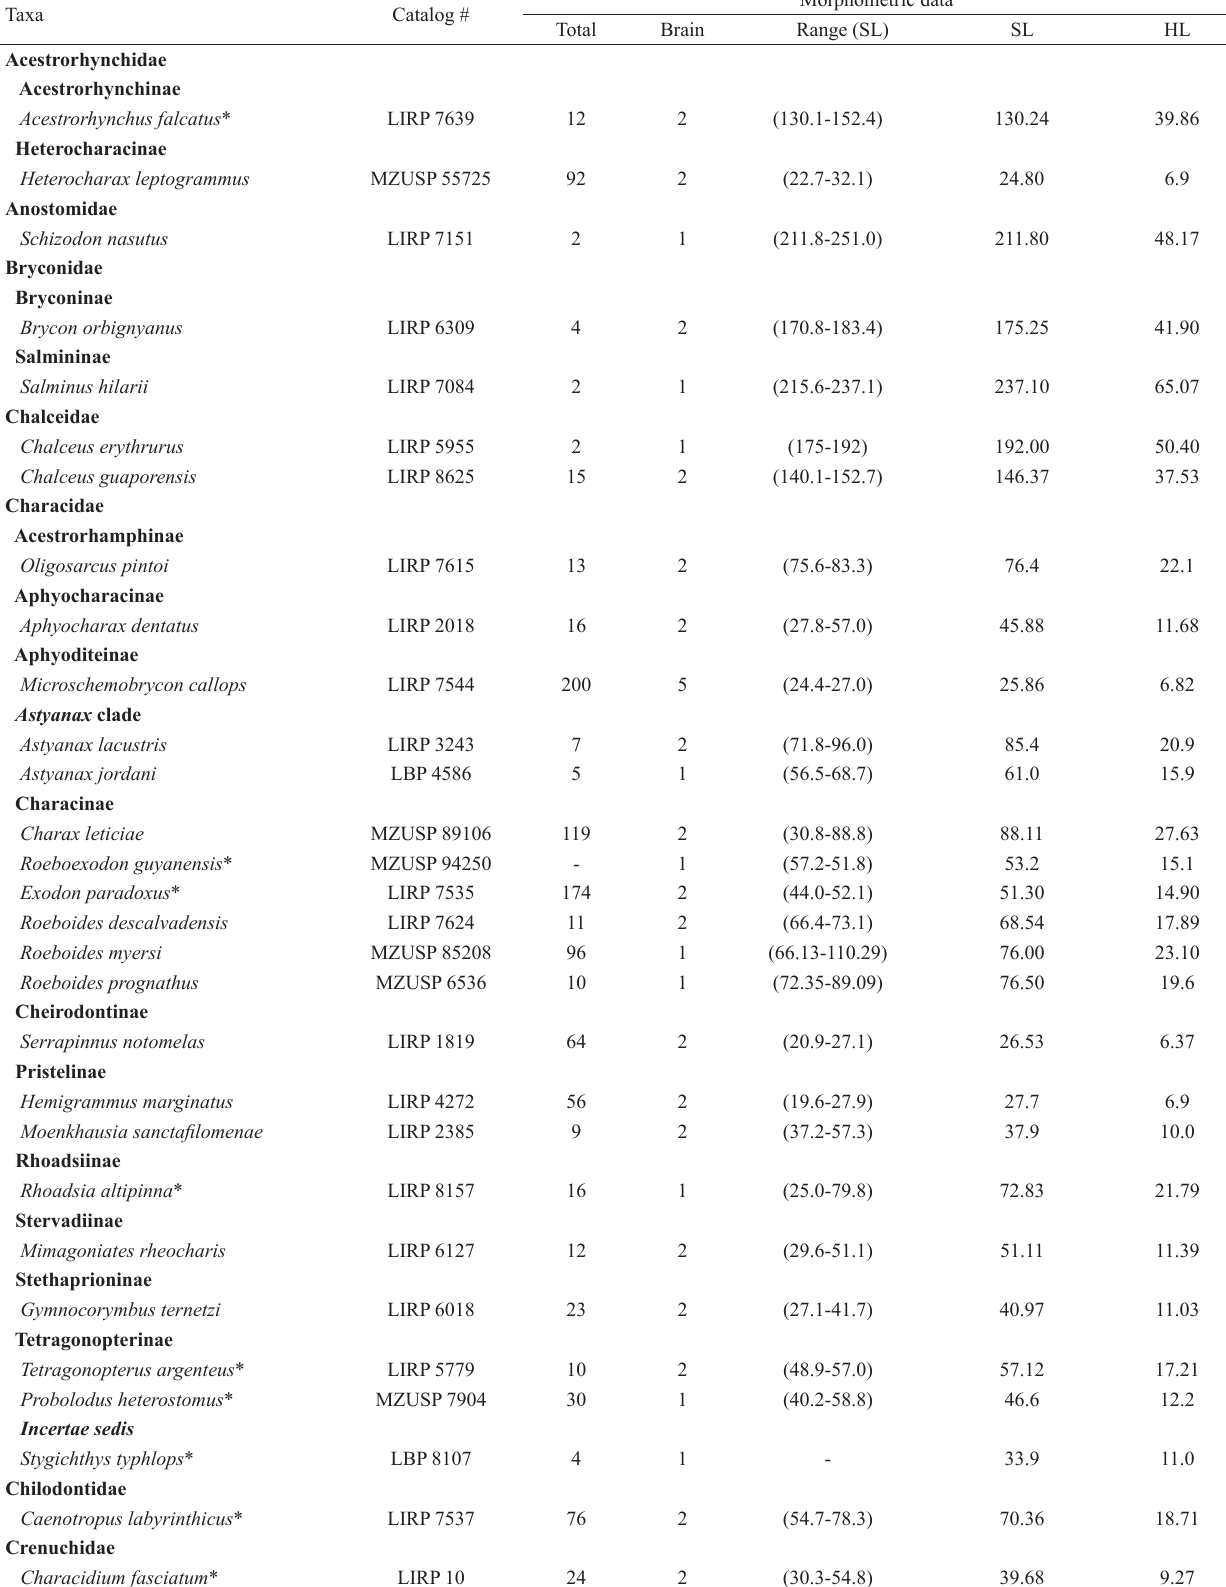
Table 1. Material examined in the present study. Asterisk represents type species of genus; SL = Standard length; HL = Head